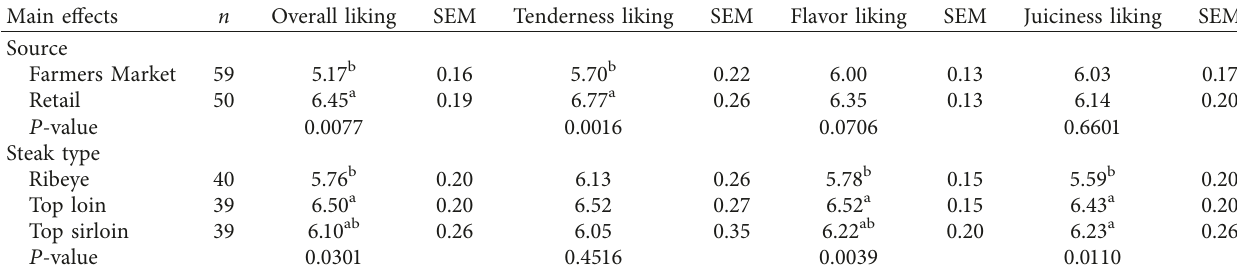
Table 8: Least squares means for sensory panel ratings 1 by source and steak type main effects.